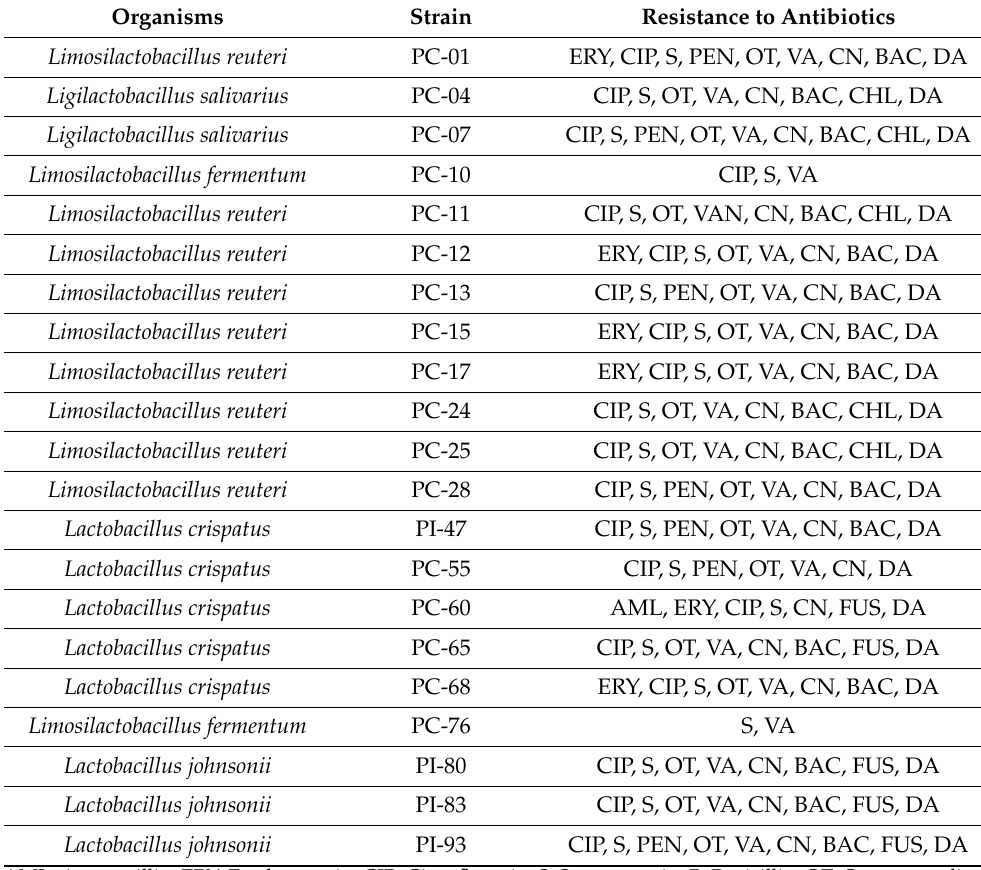
Table 3. Antibiotic resistance profile of selected